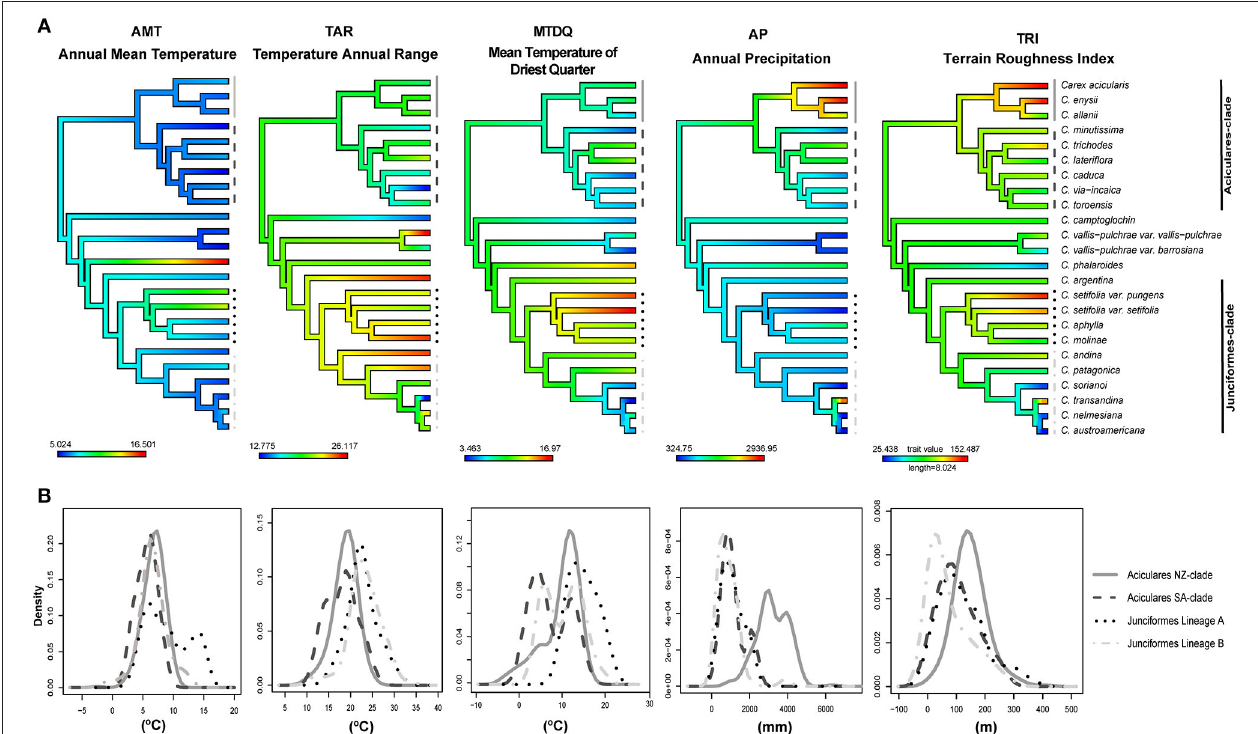
FIGURE 2 | (A) Bioclimatic niche reconstruction at ancestral nodes for five continuous environmental variables of the calibrated tree for the Carex sect. Junciformes. The ML reconstruction is represented as gradational colors along the branches. Higher values are displayed in red, intermediate in green, and low in blue. (B) Comparison of density plots expressing the frequency of distribution for the same uncorrelated variables in the four clades belonging to Carex sect. Junciformes. These clades are also represented in Figure 3C to the right of the phylogeny. ML, maximum likelihood.